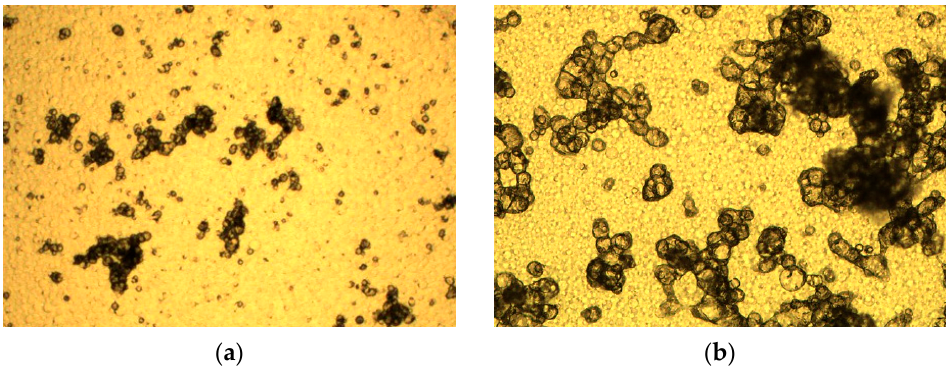
Figure 4. Light microscopy images of precipitates. ( a ) shows a magnification of 10-fold and ( b ) of 50-fold.